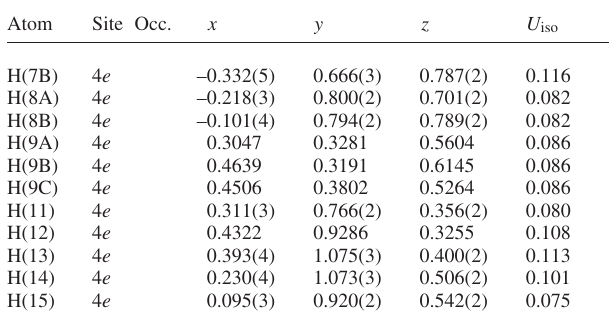
Table 2. Atomic coordinates and displacement parameters (in Å 2 )